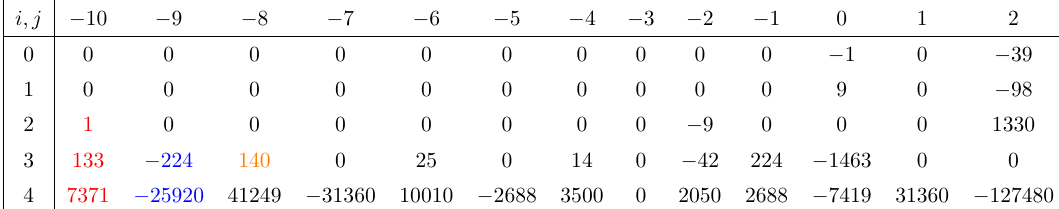
Table 16 . Series coefficients c i,j for the one-string elliptic genus of the n = 4 E 7